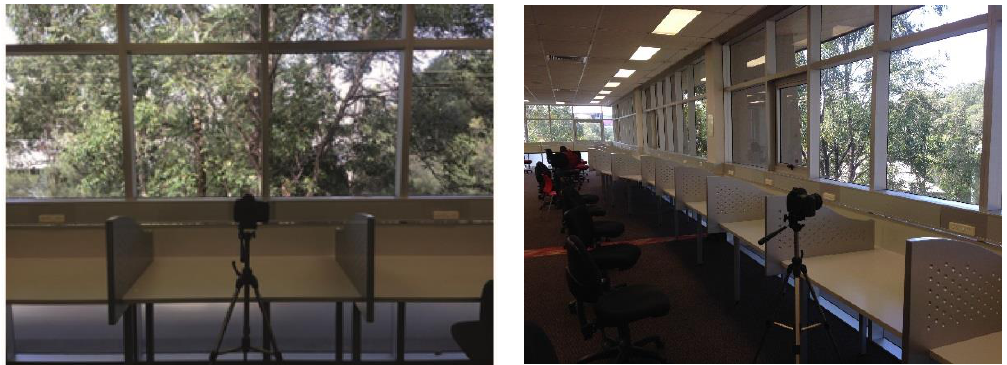
Figure 4. Example of taking high-dynamic-range (HDR) photos at each workstation.